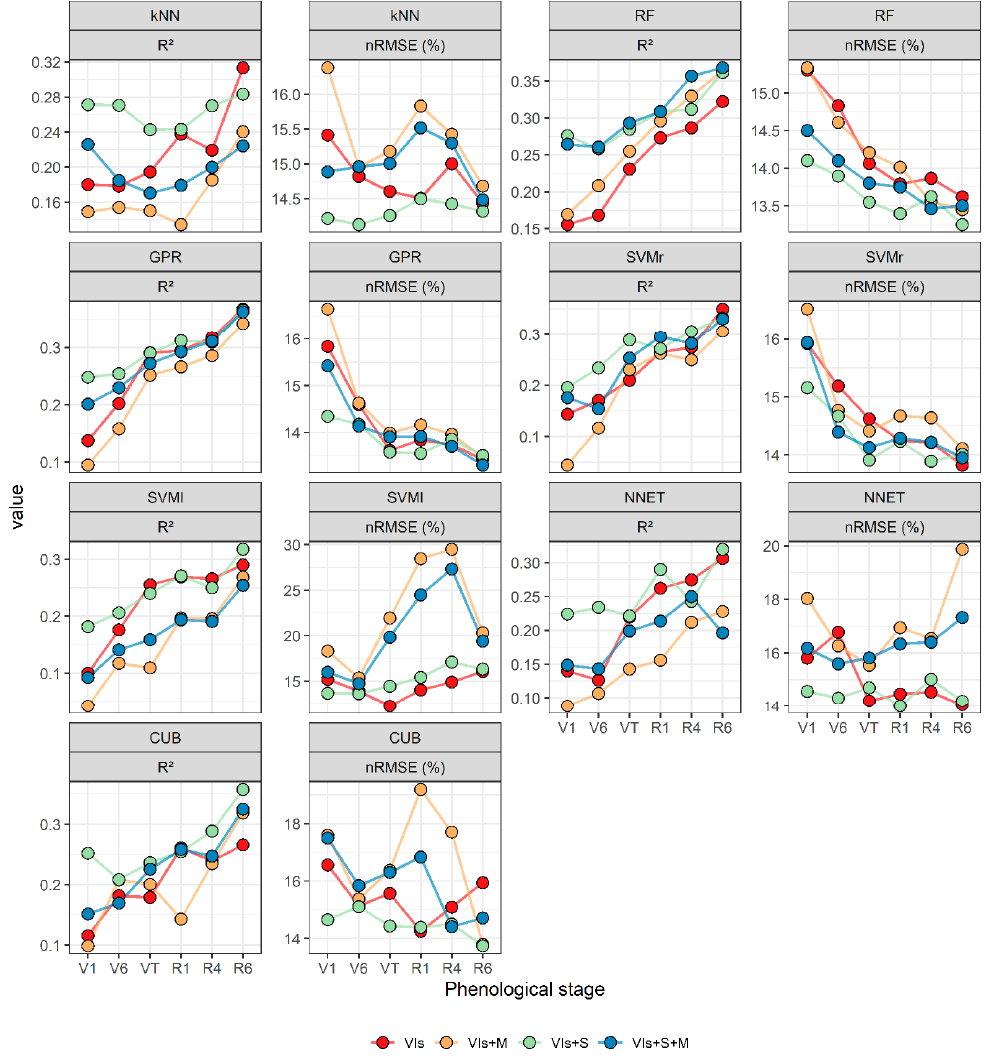
Figure 3. Model performance at six phenological stages for four feature sets (VIs, VIs + M, VIs + S, VIs + S + M) using the seven ML algorithms (kNN, SVMr, RF, CUB, GPR, SVMl, and NNET) and without principal component analysis (PCA) data reduction. The filled point represents the mean values of R 2 and nRMSE